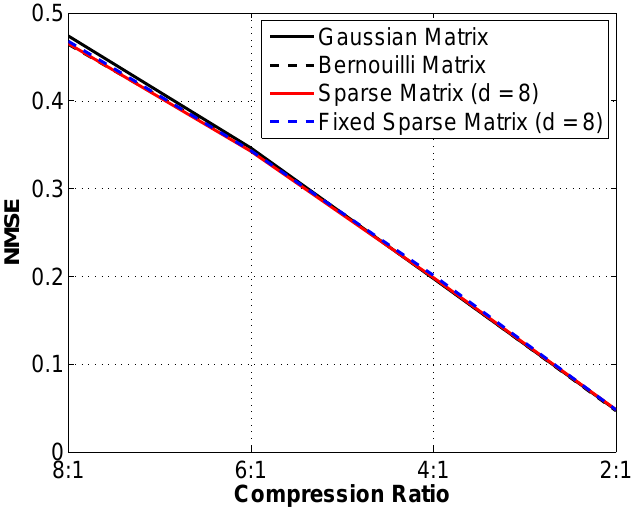
Gaussian Matrix Bernouilli Matrix Sparse Matrix (d = 8) Fixed Sparse Matrix (d =